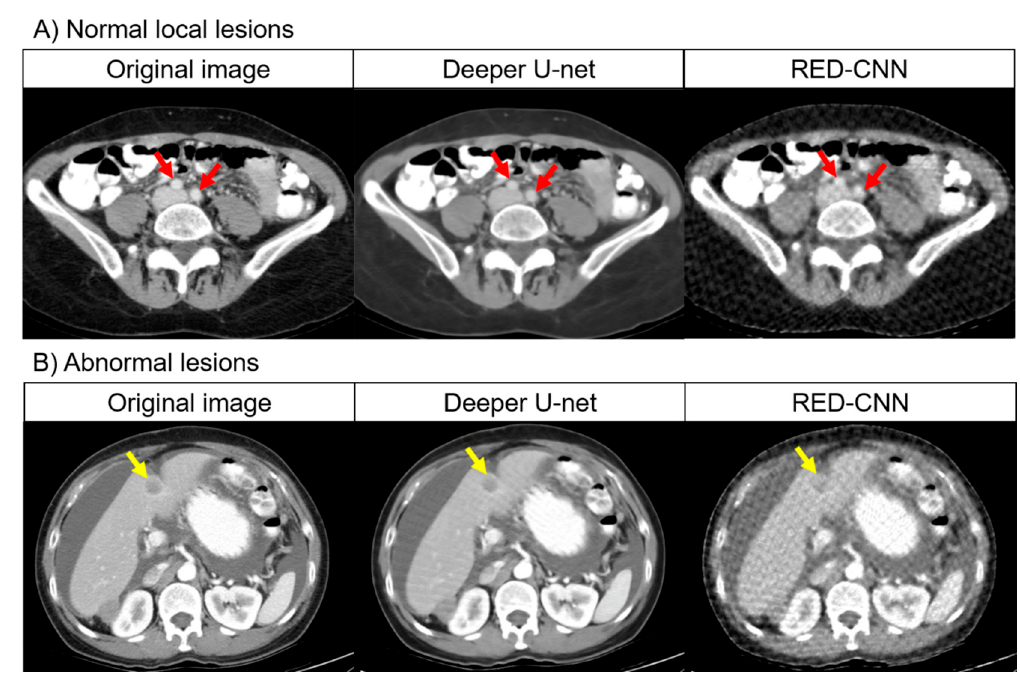
Figure 2. Representative images of the original CT and denoised CT obtained using deeper U-net and RED-CNN. Note: ( A ) Visual scores of common iliac artery (red arrow): 5 points for deeper U-net, 2 points for RED-CNN for reader 1; 4 points for deeper U-net, 2 points for RED-CNN for reader 2. ( B ) Visual scores of liver metastasis (yellow arrow): 3 points for deeper U-net, 2 points for RED-CNN for reader 1; 4 points for deeper U-net, 2 points for RED-CNN for reader 2. Abbreviation: RED-CNN, Residual Encoder-Decoder Convolutional Neural Network.